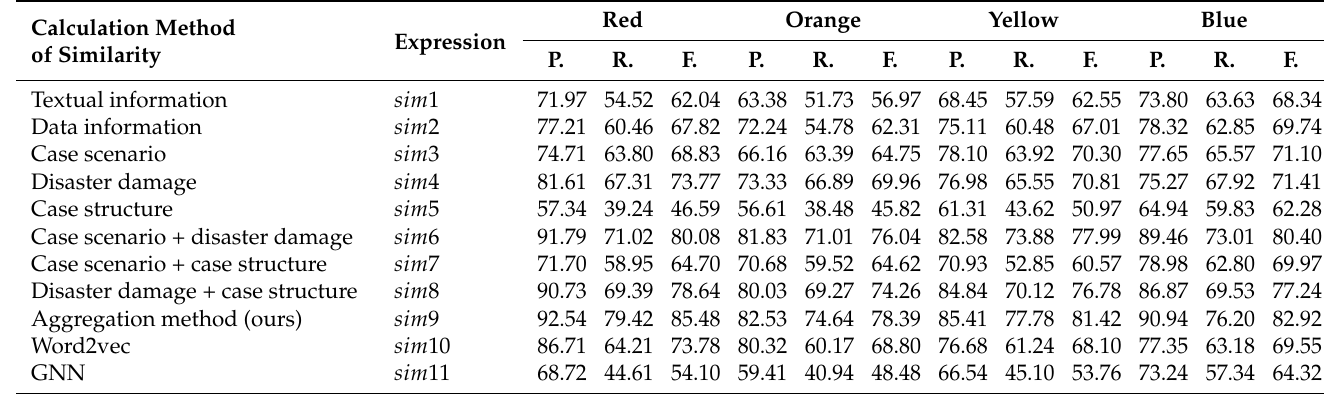
Table 4. Experimental results of similarity accuracy test in storm surge disaster